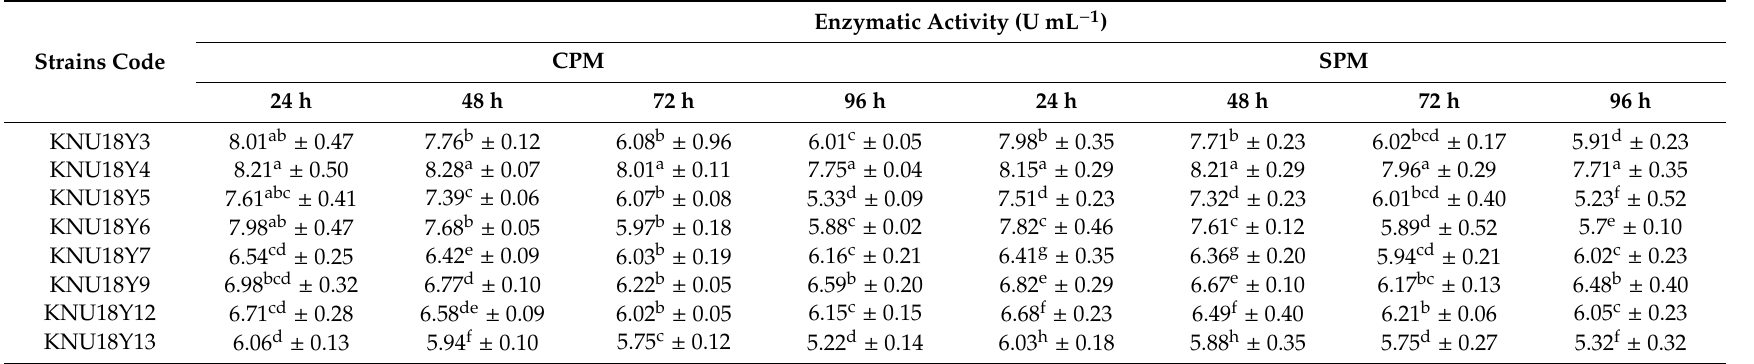
Table 8. Polygalactrunase (PG) activity of the yeasts after fermentation in CPM and SPM (24, 48, 72, and 96 h).